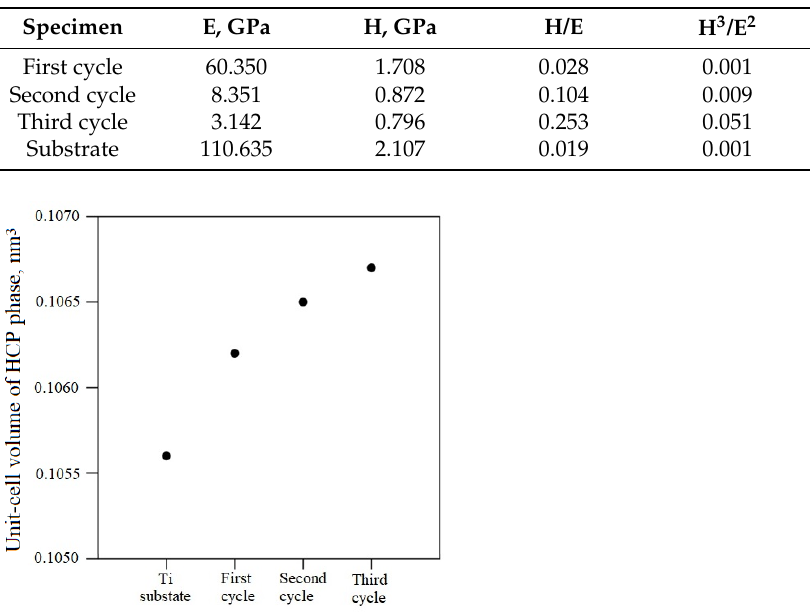
Figure 7. Unit-cell volume of the hexagonal closed-packed phase of the Ti substrate and after each cycle. each